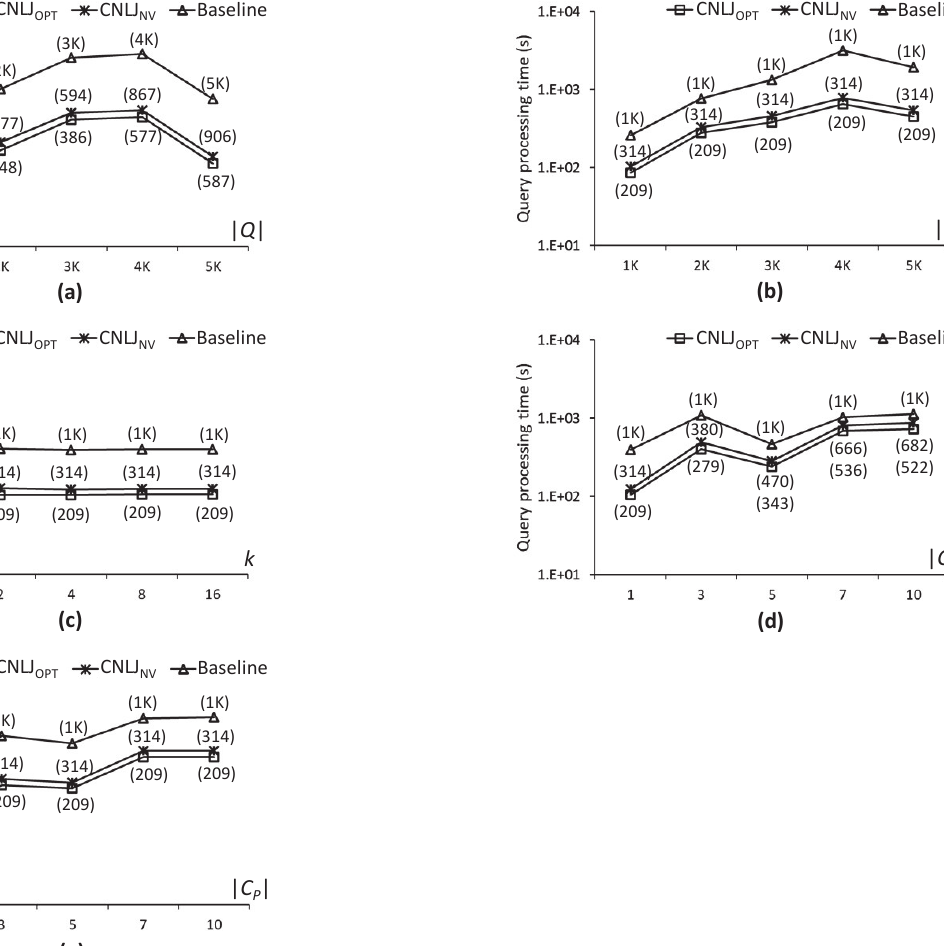
(cid:12) (cid:12) (cid:12) C Q (cid:12) ≤ 10; ( e ) 1 ≤ | C P | ≤